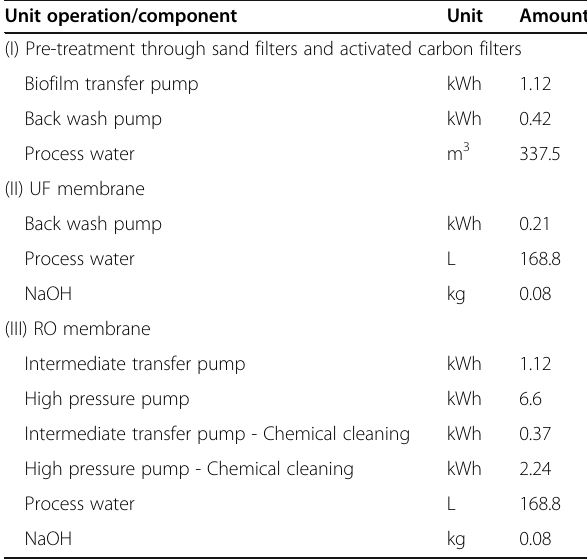
Table 2 Life cycle inventory of Combination II for integrated membrane-filtration